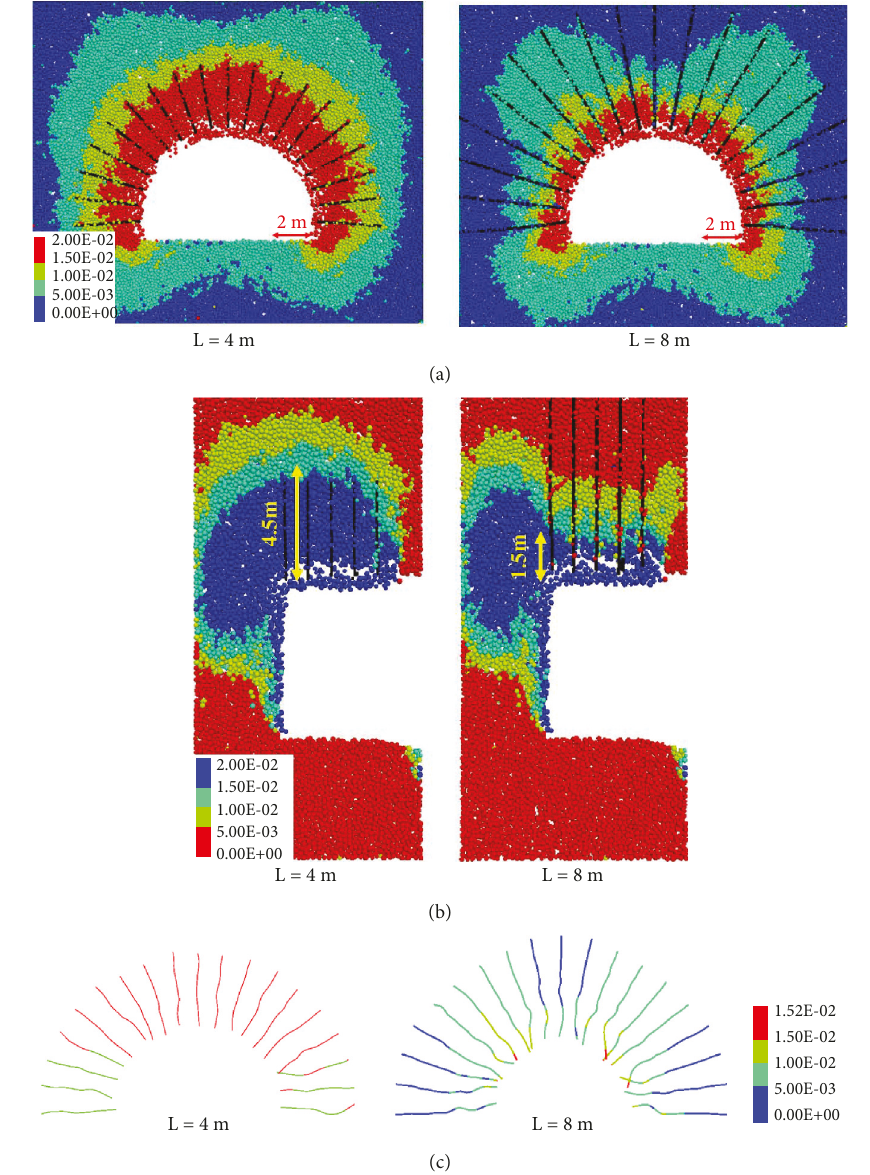
Figure 16: Support effect of long and short bolts: (a) positive view of displacement distribution of the surrounding rock; (b) side view of displacement distribution of the surrounding rock; (c) bolt deformation diagram. Unit: